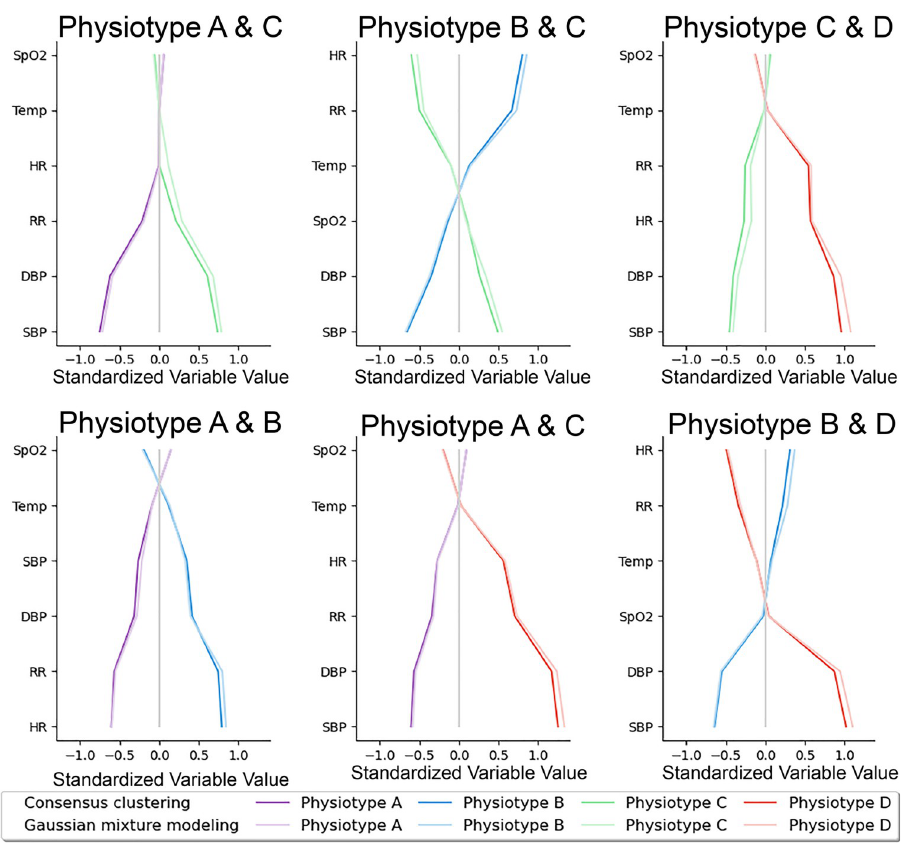
Fig 2. Vital sign contributions to cluster assignments. Pairwise physiotype comparisons of vital sign values standardized to mean 0 and standard deviation 1 demonstrated that temperature and oxygen saturation contributed least to phenotype differences. Systolic and diastolic blood pressure varied substantially between all Physiotypes except for A and B. SpO2: peripheral capillary oxygen saturation; Temp: temperature; SBP: systolic blood pressure; DBP: diastolic blood pressure, RR: respiratory rate; HR: heart